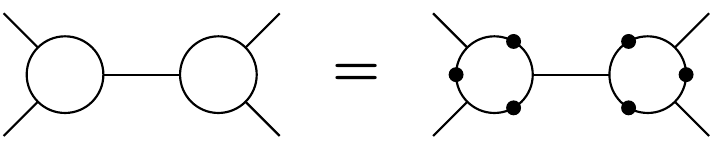
Figure 13 . A diagrams with independent loops can be reconstructed in one way only from ( n +4)- pt tree diagrams. It corresponds to nine tree-like diagrams, due to three possible locations of both ‘ 1 and ‘ 2 .